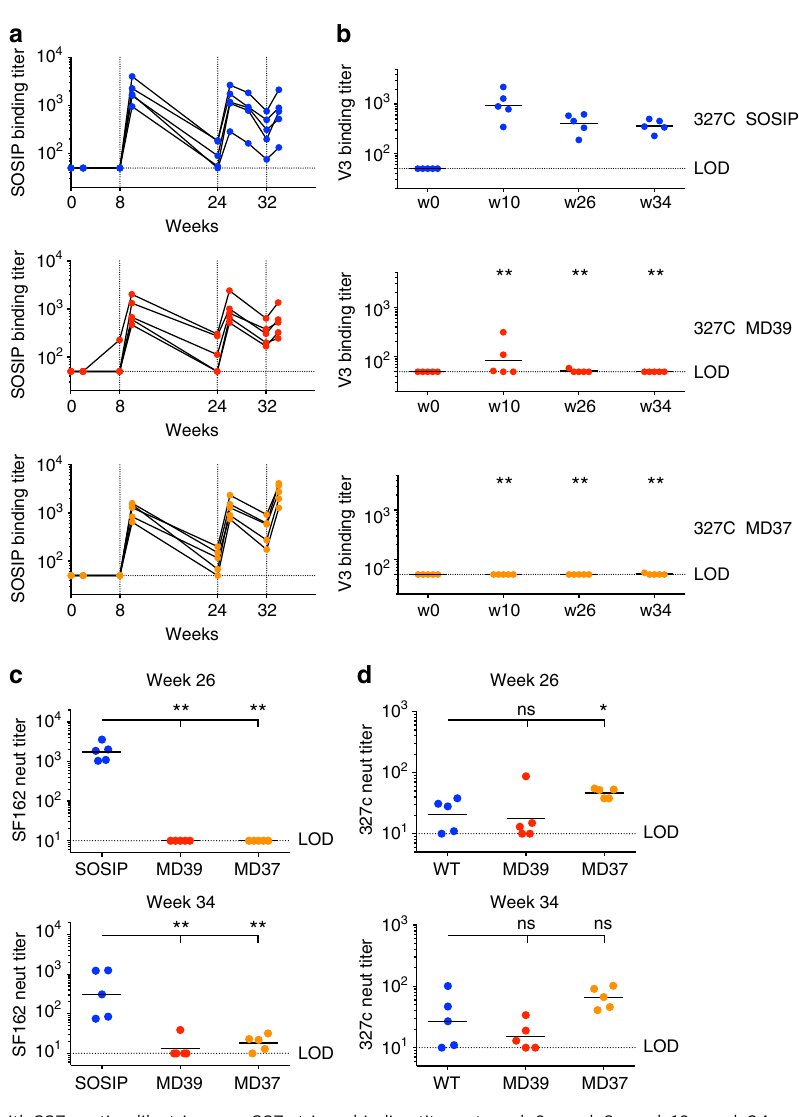
Fig. 7 Rabbit immunization with 327c native-like trimers. a 327c trimer binding titers at week 0, week 8, week 10, week 24, week 26, week 32, and week 34 time points for rabbits immunized with 327c SOSIP, 327c MD39, and 327c MD37. b V3 binding titers at week 0, week 10, week 26, and week 34 time points for rabbits immunized with 327c SOSIP, 327c MD39, and 327c MD37. The V3 peptides correspond to the V3 peptide sequence found in the matching trimer immunogen. Stars indicate the signi fi cance of differences between WT and respective stabilized designs. c Tier-1 SF162 neutralization titers at week 26 and week 34. d Autologous 327c Tier-2 neutralization titers at week 26 and week 34. Group size N = 5. The data are from one experiment. Statistical comparisons were calculated using two-tailed Mann – Whitney U tests. * indicates p < 0.05, ** indicates p <